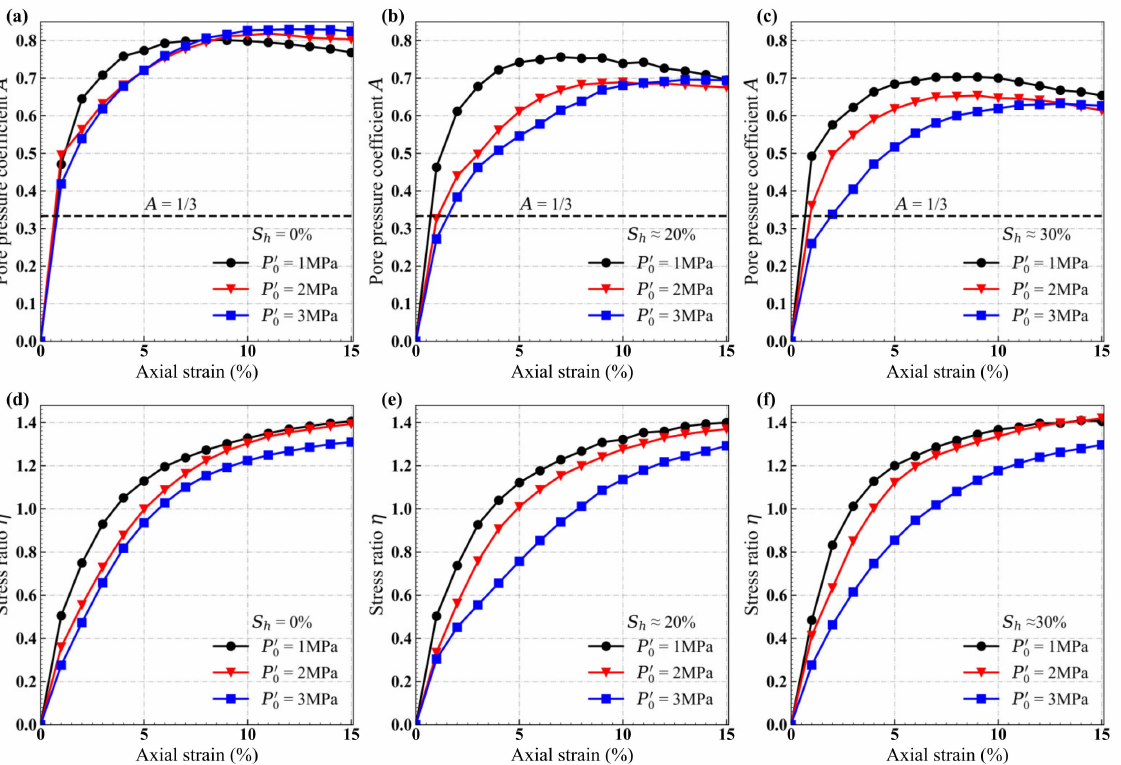
Figure 5. Effect of effective confining pressure on A value of clayey-silty sediments with ( a ) S h = 0%, ( b ) S h ≈ 20%, ( c ) S h ≈ 30%, and effect of effective confining pressure on stress ratio η of clayey-silty sediments with ( d ) S h = 0%, ( e ) S h ≈ 20%, ( f ) S h ≈